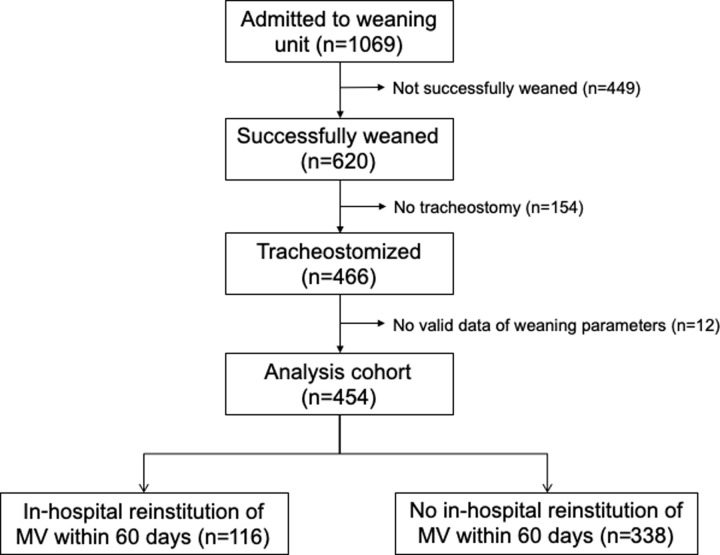
Flow diagram of patient inclusion and outcomes.